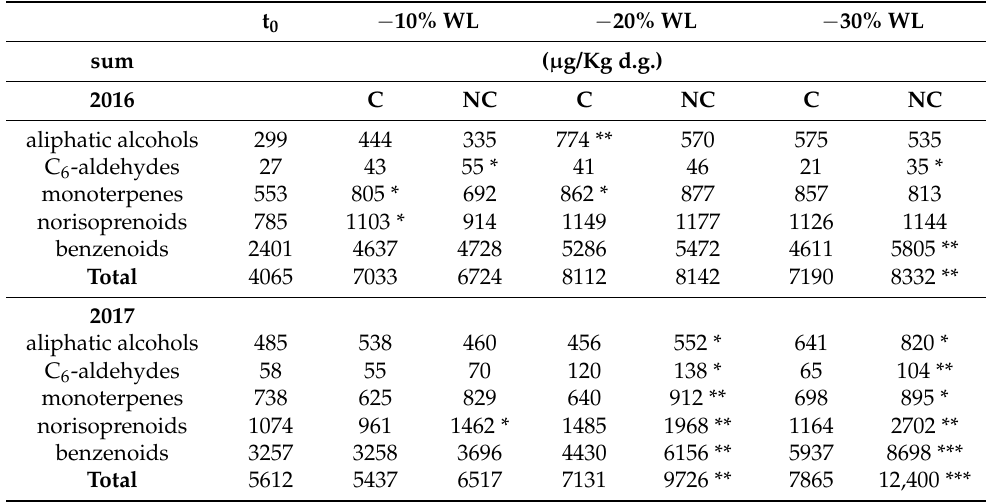
Table 1. Glycoside aroma precursors in Corvina grape during